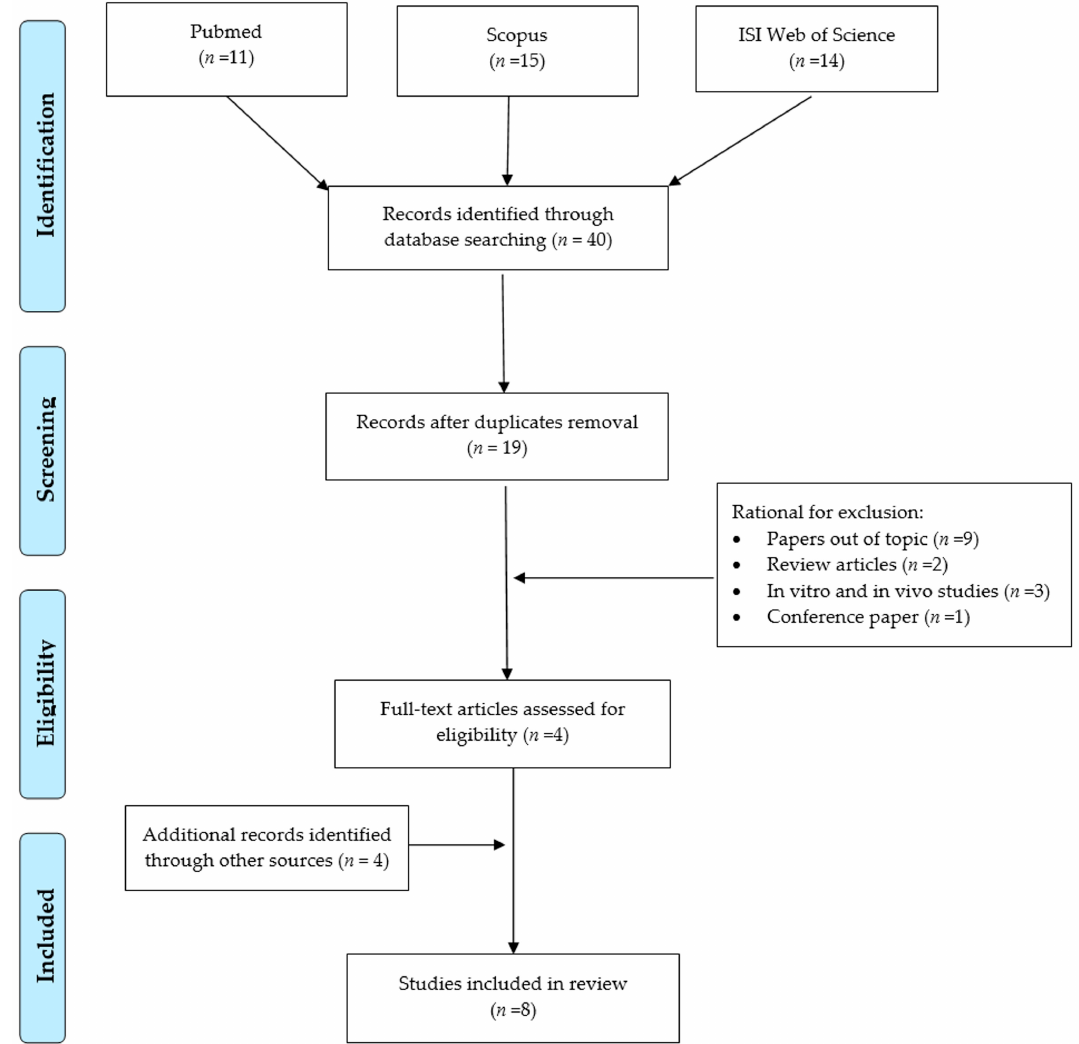
Figure 1. Flow diagram of literature search. Search string employed in the three different databases: Pubmed: ((((“Welding Fumes”) OR welder OR welding))) AND epigen*; Scopus: (TITLE-ABS-KEY (“Welding Fumes”) OR TITLE-ABS-KEY (welder) OR TITLE-ABS-KEY (welding)) AND (TITLE-ABS-KEY (epigen*)); ISI Web of Science: ALL = (“Welding Fumes” OR welder OR welding) AND ALL = (epigen*).